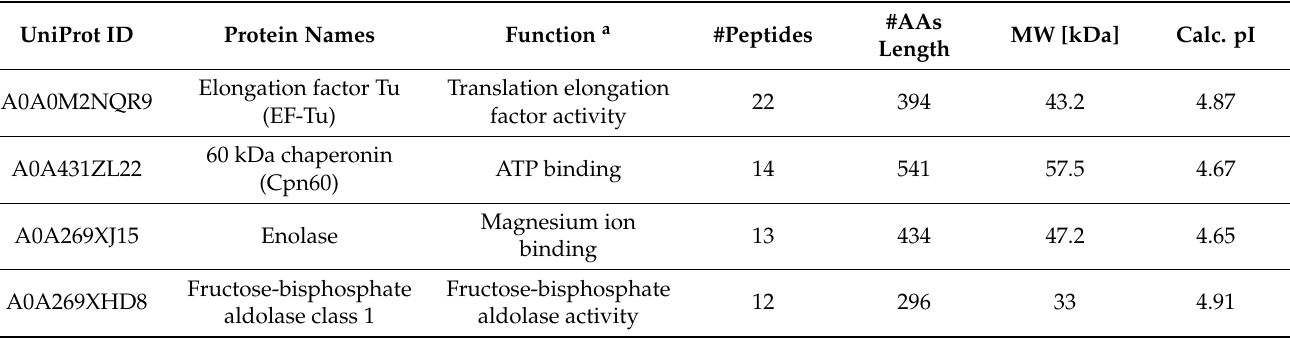
Table 1. List of functionally important proteins identified from culture supernatant of estrus-specific S. pasteuri